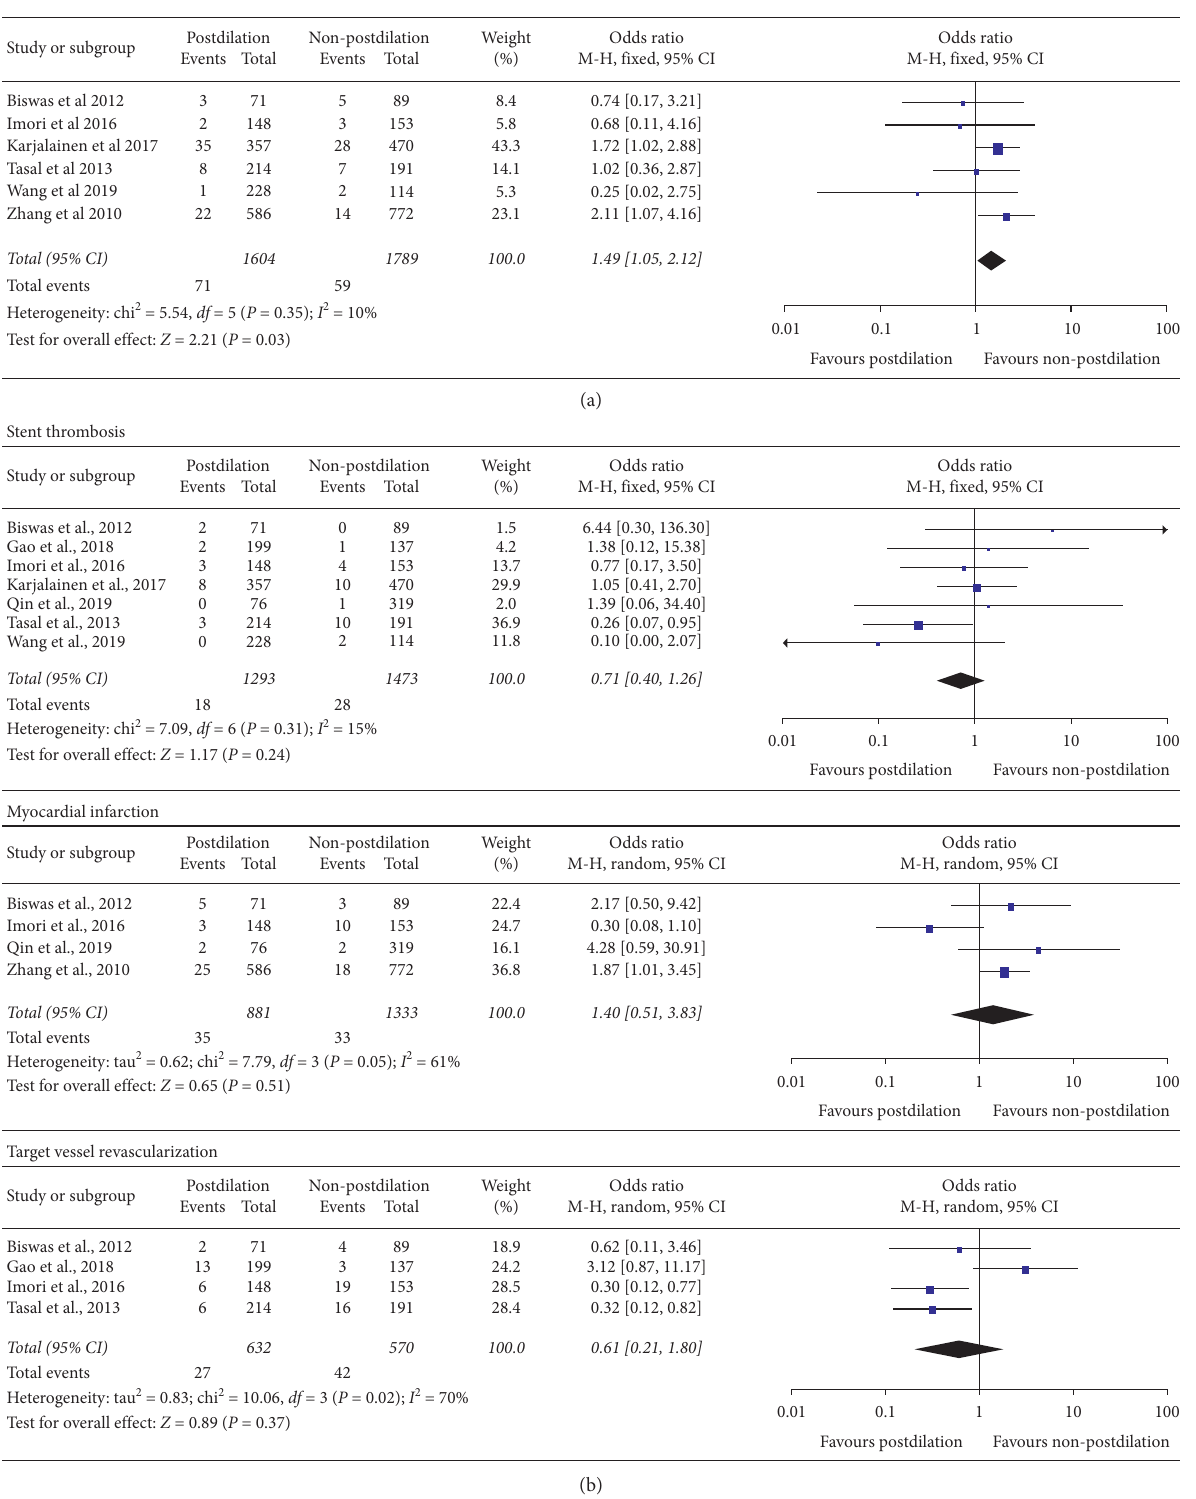
Figure 3: Forest plots of secondary clinical outcomes between postdilation and non-postdilation